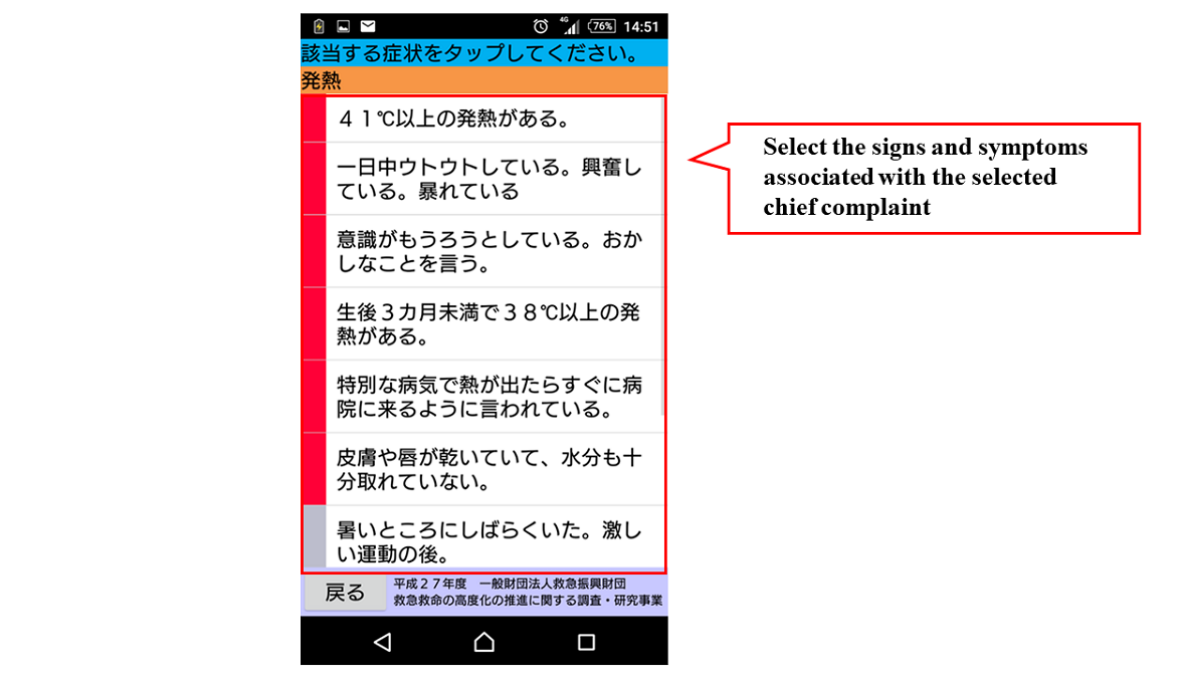
Figure 5. Screenshot about selection of signs and symptoms related to the selected chief